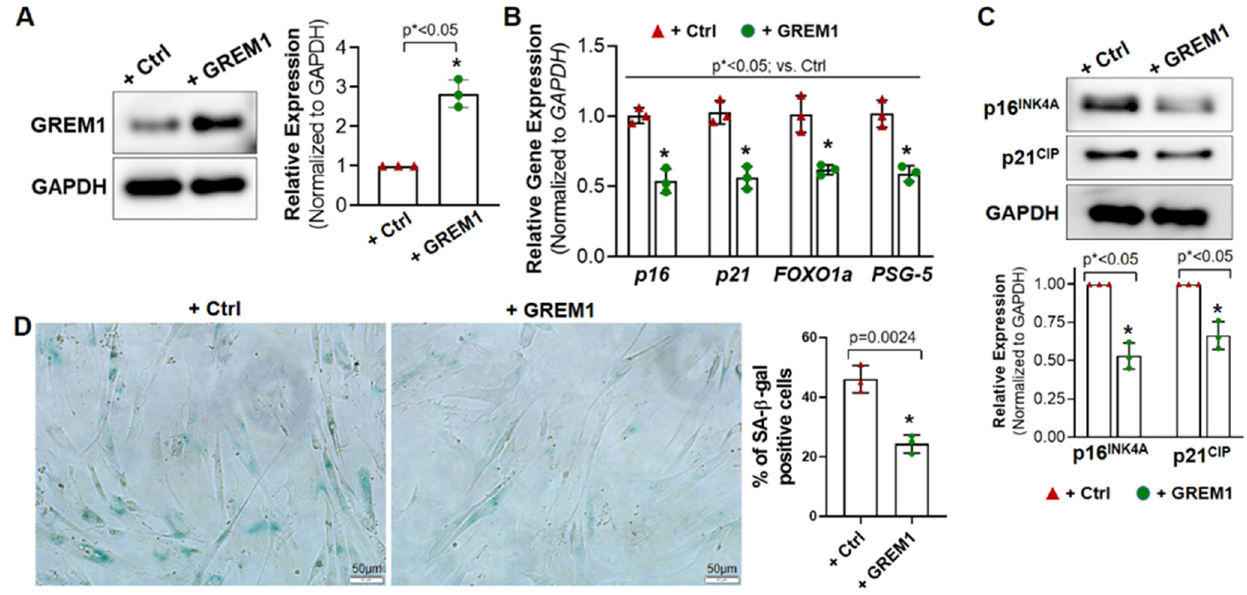
Figure 2. Overexpressing GREM1 rejuvenates the senescent phenotype of aged hMPCs. ( A ) Western blot analysis confirmed the overexpression of GREM1 after infecting hMPCs with lenti-GREM virus or control (Ctrl) lentivirus. n = 3 independent experiments. ( B ) qPCR for the gene expression of p16, p21, Foxo1a, and PSG-5 in aged hMPCs (AMC145) after overexpressing GREM1. n = 3 independent experiments. ( C ) Western blot analysis showed the protein level of p16 and p21 in aged hMPCs (AMC145) after overexpressing GREM1. n = 3 independent experiments. ( D ) Representative images and quantitative analysis of SA- β -gal staining in aged hMPCs (AMC145) after overexpressing GREM1. Data are mean ± SEM. p value was calculated by unpaired Student’s t -test, n ≥ 3 independent experiments. * indicated the significant difference compared to the control group.